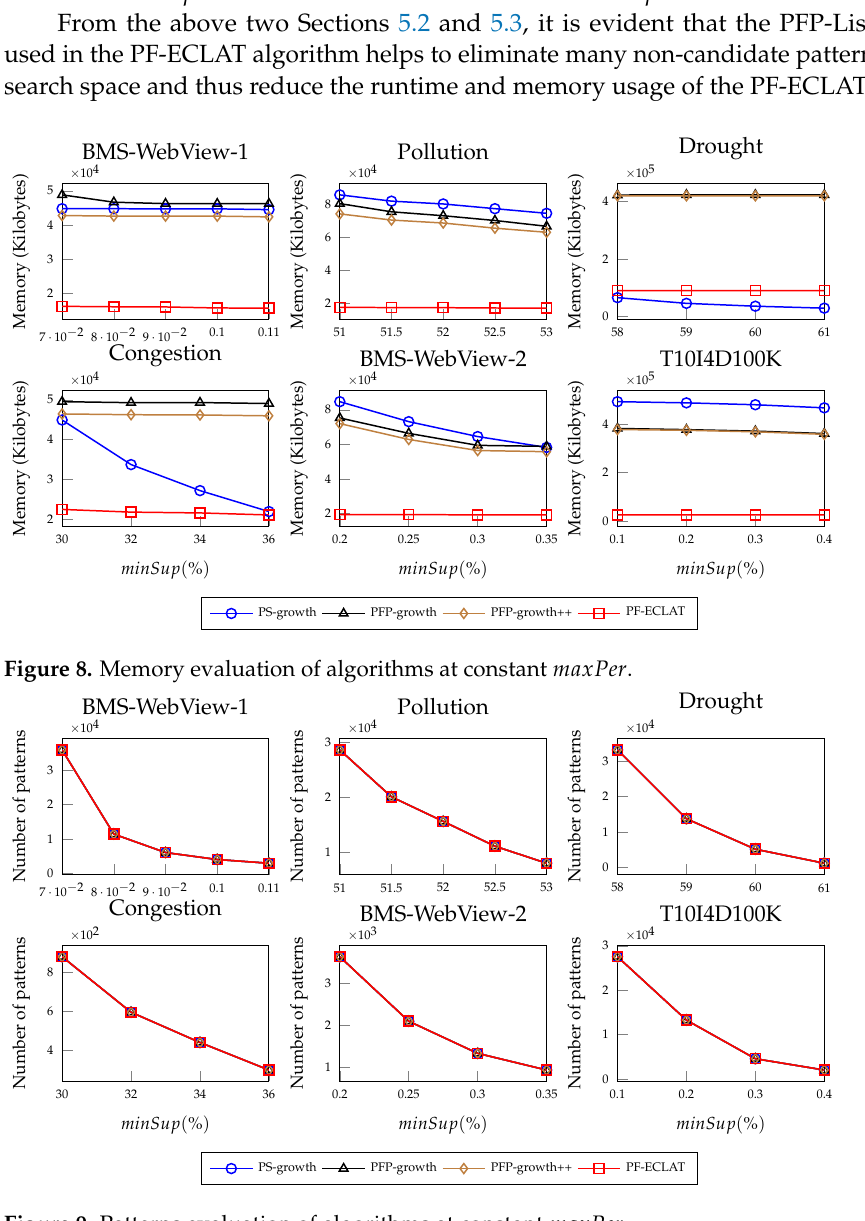
Figure 9. Patterns evaluation of algorithms at constant maxPer